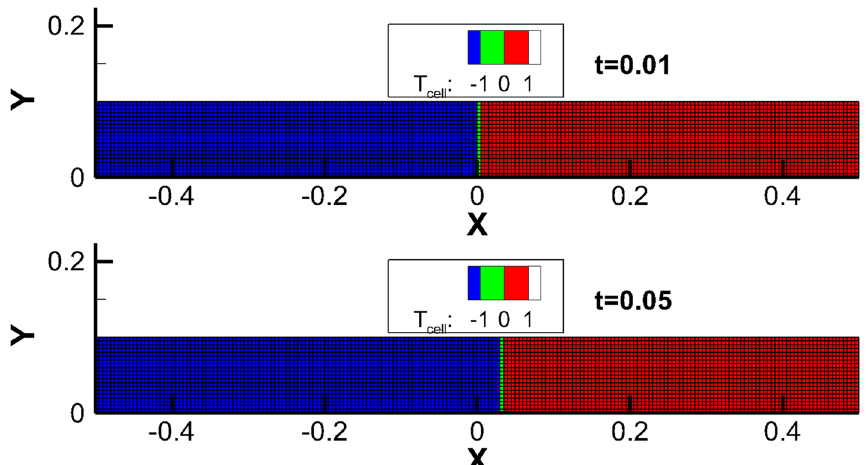
Fig. 22 Distribution of the DUGKS cell and the N-S cell for unsteady gas expansion in a channel at different